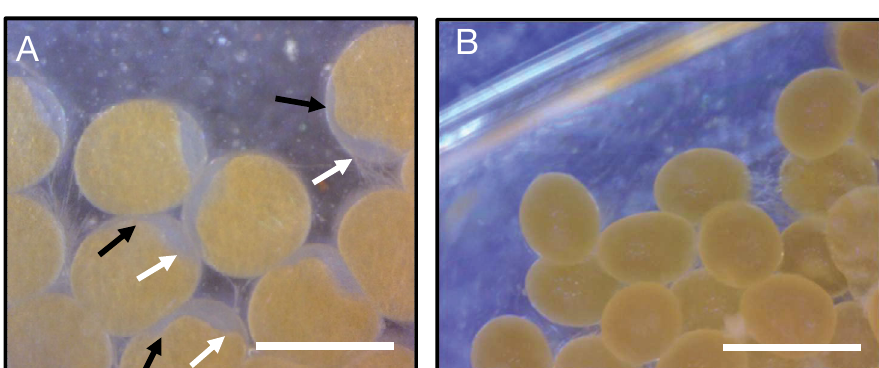
Fig. 5. Egg development following artificial insemination. (A) Positive control: embryonic development 6 d after insemination of Macrobrachium vollenhovenii eggs with conspecific spermatophore. The embryos are visible and their heads and tails are marked with white and black arrows, respectively. Bar represents 0.2 mm. (B) Treatment group: unfertilized M. vollenhovenii eggs, 4 d after insemination with M. rosenbergii spermatophore. No embryo development is apparent. Bar represents